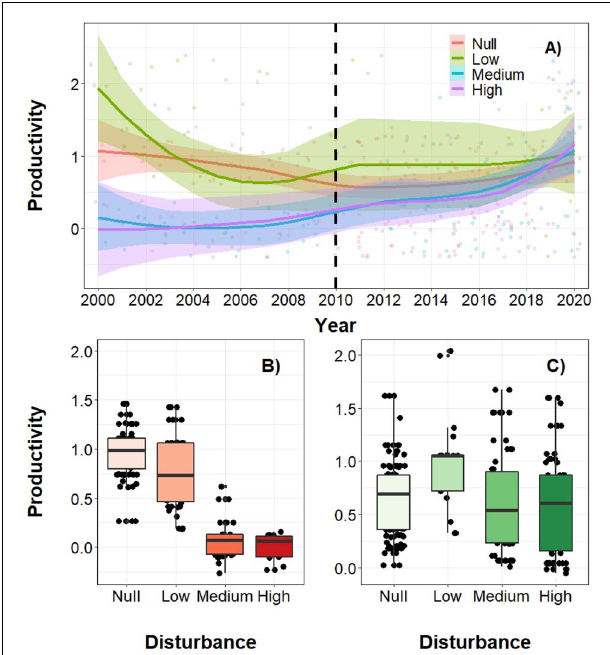
FIGURE 3 | The figure (A) Temporal trends in the number of fledglings per breeding pair (pairs that lay at least one egg) during the whole study period (2000–2020) considering the disturbance regime (null, low, medium, and high) that affected the breeding territories before and after the management action plan. Shaded areas represent 95% confidence intervals. The dashed vertical line shows the beginning of the management actions (2010). The (B,C) graphs showed the predicted values for productivity (i.e., number of fledglings successfully raised per pair that started reproduction) depending on the disturbance regime before (2000–2009) and after (2010–2020) adaptative management, respectively. Boxplots show the median, the upper and lower quartiles and whiskers indicate variability outside them. Colored and black dots represent the raw data points in each case.